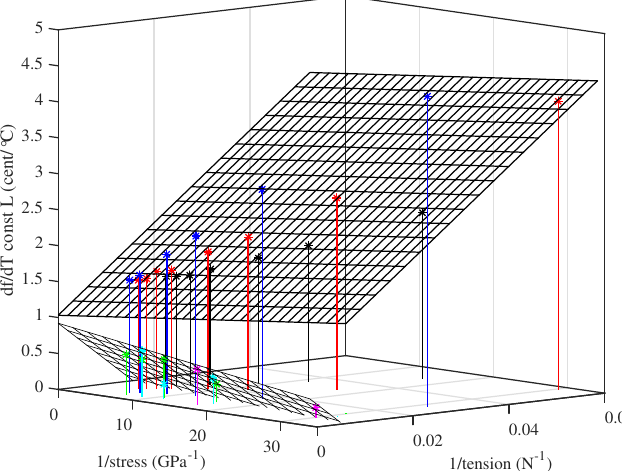
Figure 14. The thermal tuning sensitivity, plotted as a function of the inverse of stress and the inverse of tension, for the strings held at constant length with no tuning adjustments. The y -axis shows the rate of change of fundamental frequency f 1 with temperature T . Colours identify the di ff erent tested strings (Table 1): black (8:A6), red (14:A5), blue (5:A4), green (23a:A3), cyan (29:E3), magenta (10b:A2).